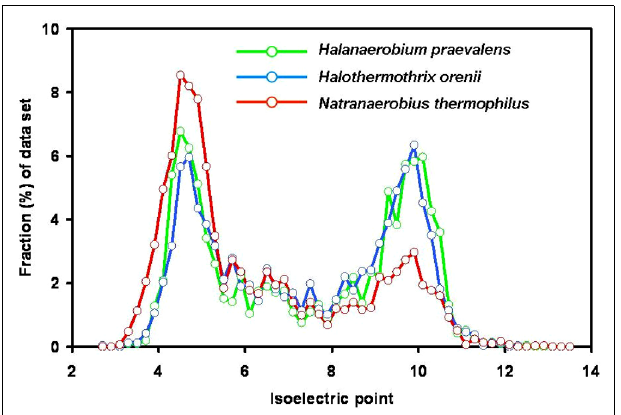
FIGURE 2 | Isoelectric point profiles, calculated at 0.2 intervals, of predicted proteins encoded by the genomes of the three fermentative halophilic anaerobes: Halanaerobium praevalens GSL T (2,110 proteins; median pI 7.42), the thermophilic Halothermothrix orenii H168 T (2,365 proteins, median pI 7.41) and the alkaliphilic and thermophilic Natranaerobius thermophilus JW.NM-WN-LF T (2,906 proteins; median pI 6.27) . From the genome annotations (Mavromatis etal., 2009; Ivanova etal., 2011; Zhao etal., 2011) sequences encoding proteins or putative proteins were extracted, and pI profiles were calculated as for Figure 1 . With kind permission from Springer Science + Business Media: Extremophiles, compiled from data presented in Elevi Bardavid and Oren (2012a) – Figure 1 , and Elevi Bardavid and Oren (2012b) – Figure 4